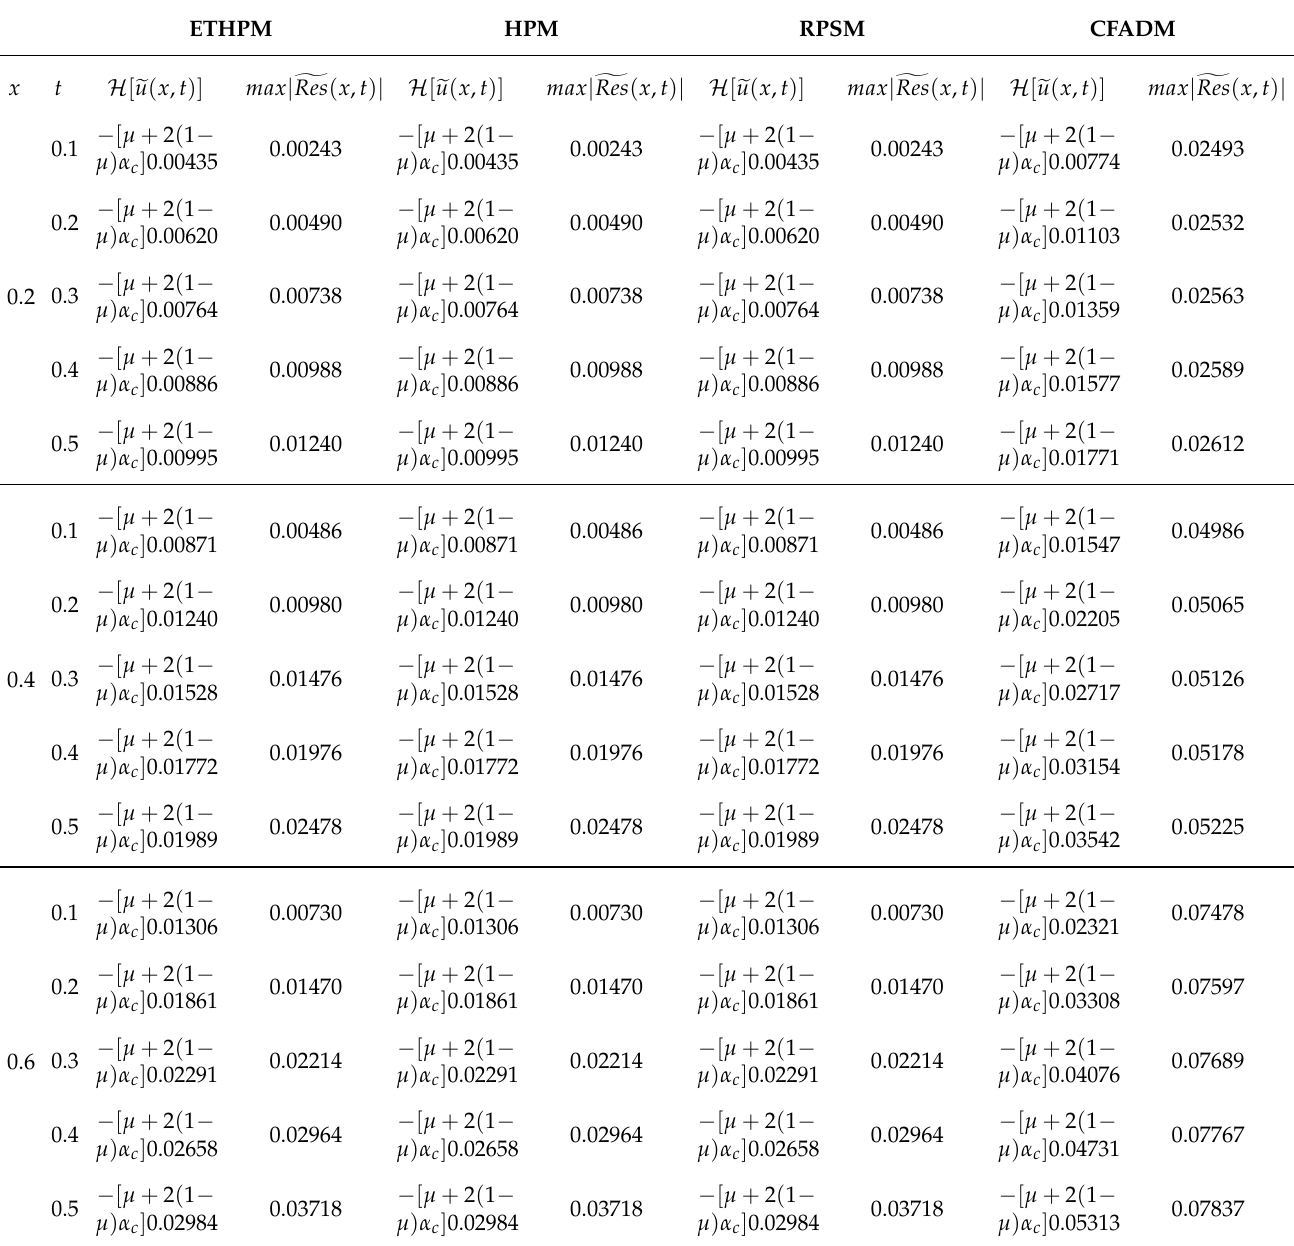
Table 4. H [ (cid:101) u ( x , t )] and max | (cid:103) Res ( x , t ) | by ETHPM, HPM, RPSM, CFADM for α = 0.5.